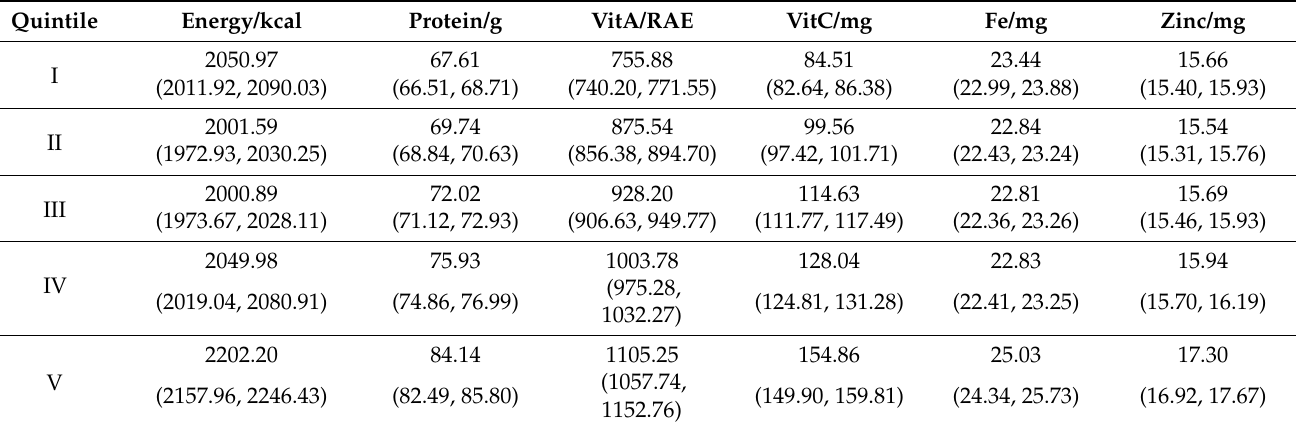
Table 3. Average daily nutrient availability per capita, adjusted by equivalence scales, by income quintiles (Mexico, 2020).